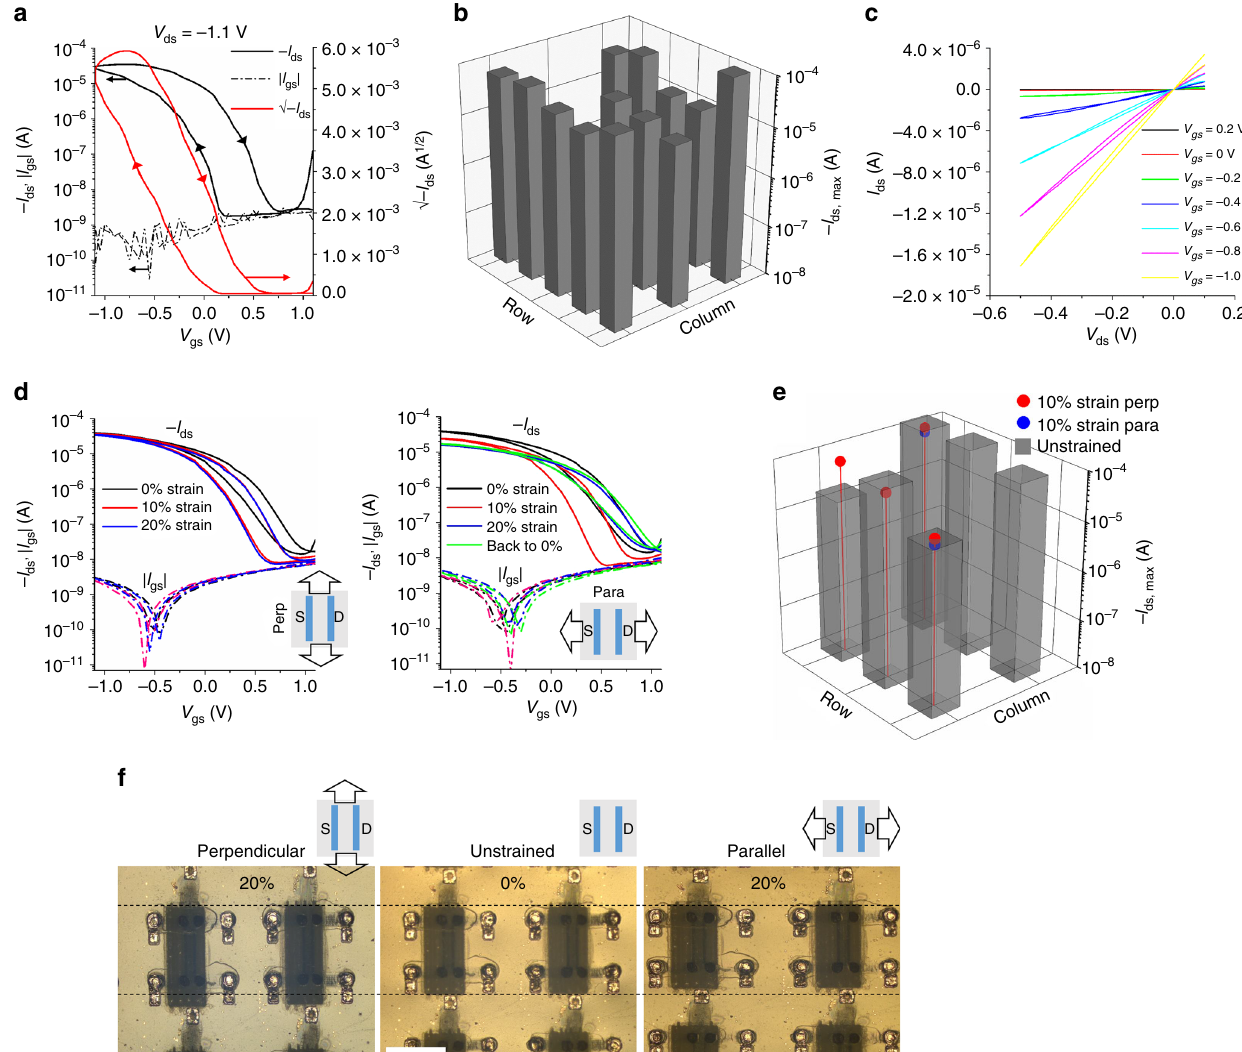
Fig. 3 Electrical characterization of the inkjet (IJ)-printed stretchable fi eld effect transistors (FETs). a Transfer curve and square root of source – drain current √ − I ds vs. gate voltage ( V gs ) of a representative IJ-printed intrinsically stretchable single-walled carbon nanotube-FET (SWCNT-FET). b Map of the max drain – source current ( − I ds,max ) in saturation regime for each FET in an array of 5 × 3. The non-plotted devices were not functional. c Output characteristics at different gate voltages. The W / L of the all the devices was 1000 µ m/50 µ m. d Overlapped transfer curves of the IJ-printed SWCNT-FET subjected to different strain conditions along the two main directions: perpendicular (left) and parallel (right) to the channel length. e Map of − I ds,max in saturation regime for each FET in an array of 3 × 2 unstrained and stretched 10% in the directions perpendicular (perp) and parallel (para) to channel length. Current measurements under strain are available only for some representative devices due to setup limitations and yield loss resulting from the heavy handling involved in the stretching experiment. f Optical microscope images of some transistors stretched at 20% strain along the two main directions. The dashed lines serve to highlight the change in size of the stretched transistors when compared to the reference transistor (0% strain) in the middle. The scale bar is 1